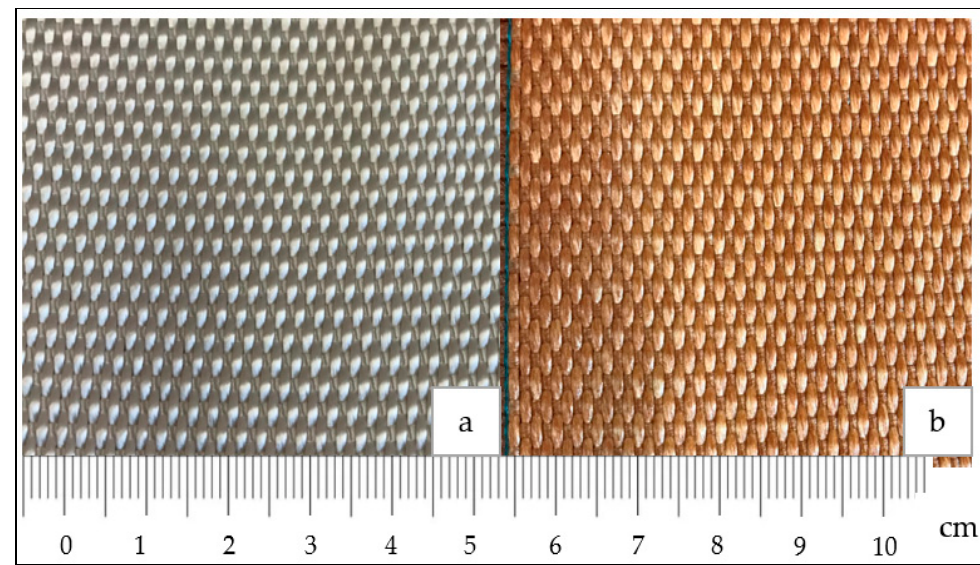
Figure 2. EP 200 woven fabric samples. ( a ) Greige fabric; ( b ) Dipped fabric.